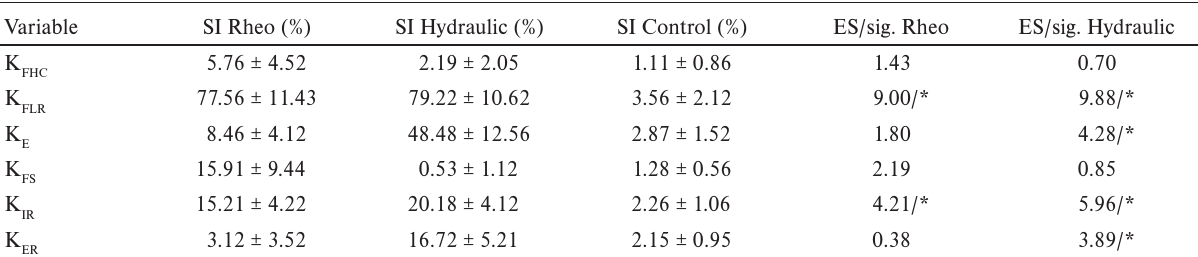
Symmetry indexes for knee joint angles for bionic knee joints (SI Rheo), hydraulic knee joints (SI Hydraulic) and the control group (SI Control) Variable SI Rheo